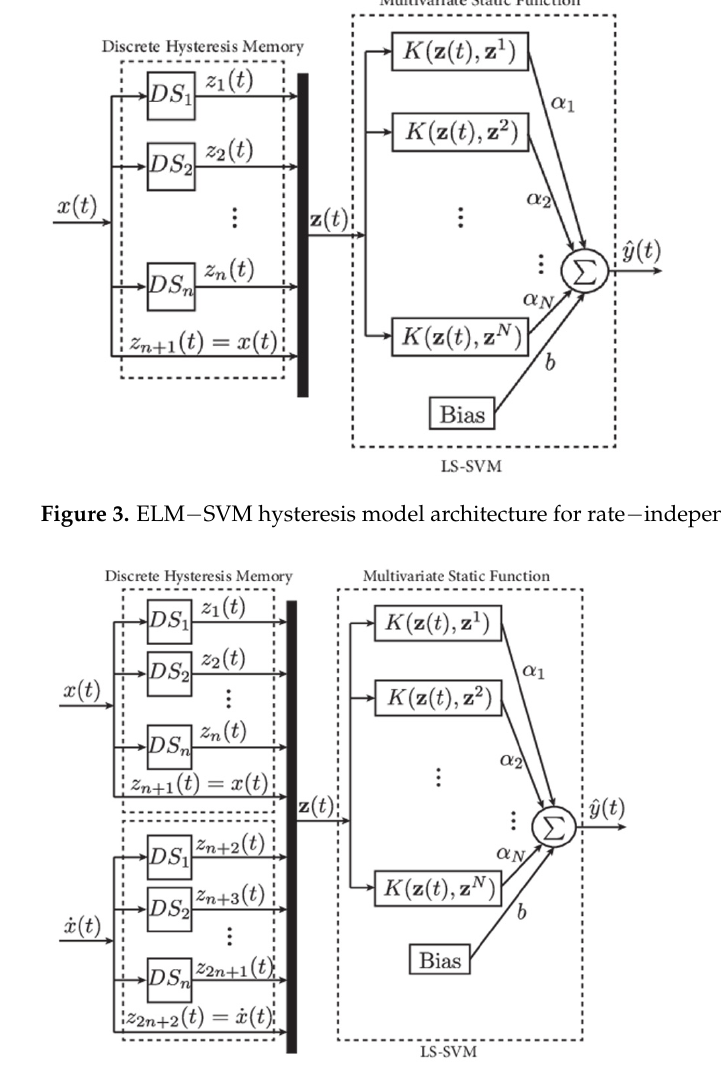
Figure 4. ELM − SVM hysteresis model architecture for rate − dependent hysteresis .